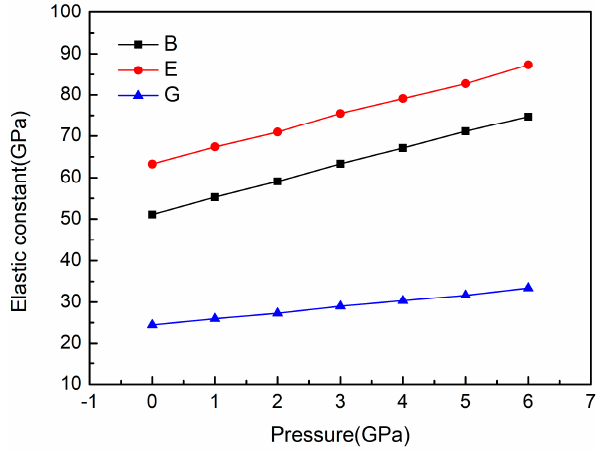
Figure 6. Elastic modulus of Mg 23 Al 30 under di ff erent pressures.